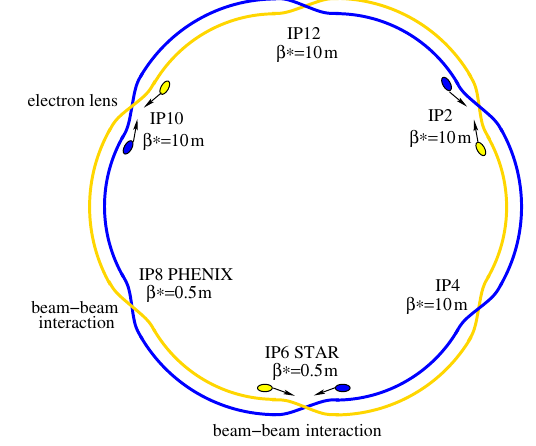
FIG. 1. Layout of head-on beam-beam compensation in RHIC. The two proton beams collide at IP6 and IP8. The e-lens in the blue ring is on the south side of IP10, and the e-lens in the yellow ring is on the north side of